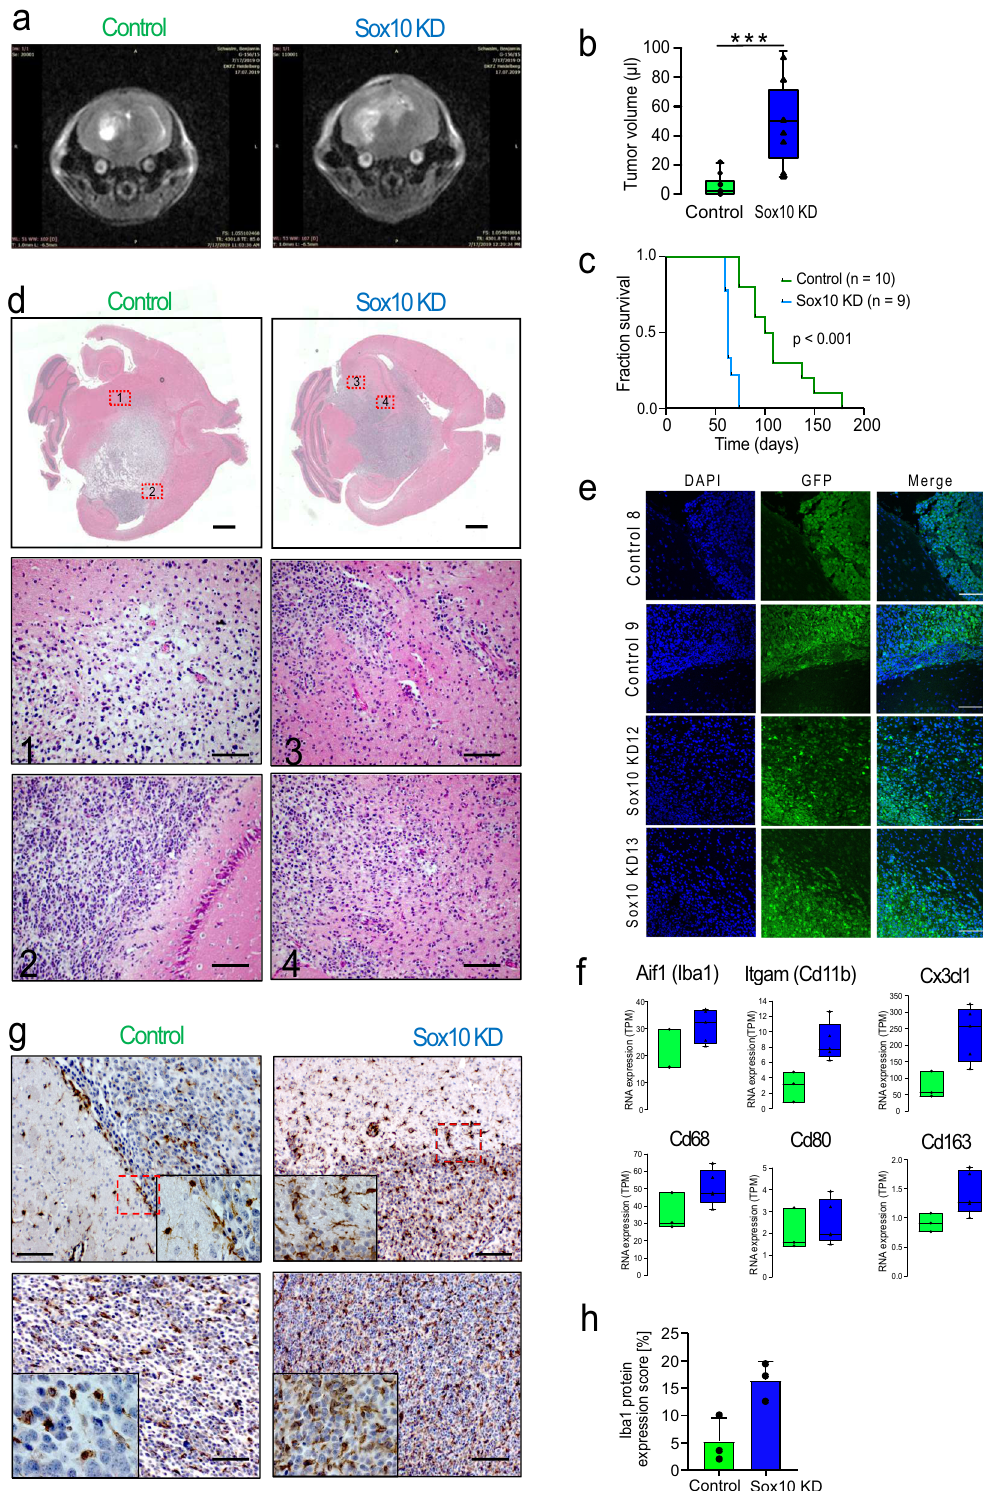
RNA-seq of GB cell lines (LN229 and ZH487, Control vs. shOX10) were performed using the polyA-selected RNA-seq libraries preparation protocol with the TruSeq stranded RNAseq Illumina kit by the DKFZ genomics & Proteomics core facility. Libraries were multiplexed-sequenced using 1 lane on a HiSeq 2000 v4, generating 50bp single-end reads. RNA-seq libraries preparation of mouse tumour samples (shNT, n = 3; shSOX10, n = 5) were also used in the above mentioned PolyA protocol. Libraries were multiplexed-sequenced using 2 lanes on a HiSeq 2000 v4, generating 50bp single-end